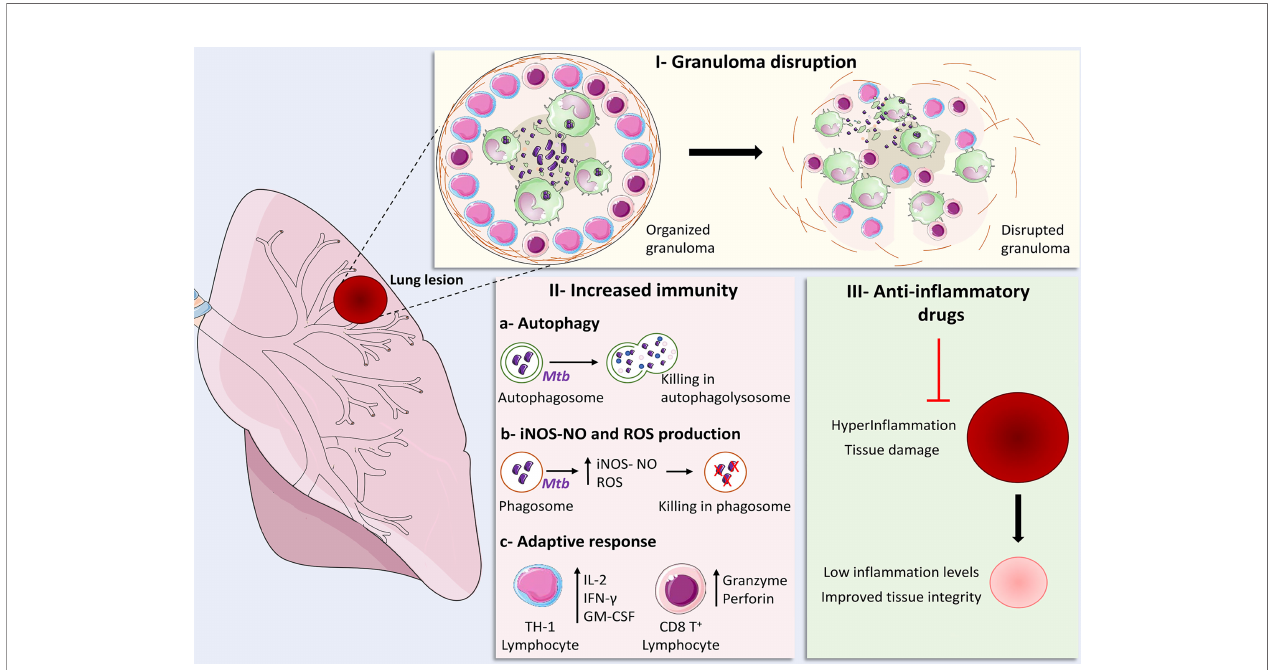
FIGURE 1 | Main strategies for the development of Host-Directed Therapies for tuberculosis. I – Granuloma disruption: strategies focused at granuloma disruption employed in conjunction with antibiotic therapy aim to loosen granuloma structure in order to promote improved drug penetration and lymphocyte migration to regions where infected cells are located; II – Increased immunity: (A) enhancement of autophagy-mediated bacterial elimination, (B) ROS and iNOS-NO-dependent bacillary killing, as well as (C) increased Th1 responses and cytotoxic CD8 + T cell effector activity can be achieved though infusion of cytokines, administration of repurposed drugs and nutritional supplementation; III – Anti-in fl ammatory drugs: The use of several families of anti-in fl ammatory drugs were tested in experimental models and clinical trials in order to restrict the damage in fl icted to host tissues by exaggerated in fl ammatory responses, which resulted in decreased or optimized production of pro-in fl ammatory mediators, improving tissue integrity and immune responses against the bacteria. Some elements in this fi gure use pictures from Servier Medical Art (https://smart.servier.com) licensed under a Creative Commons Attribution 3.0 Unported License